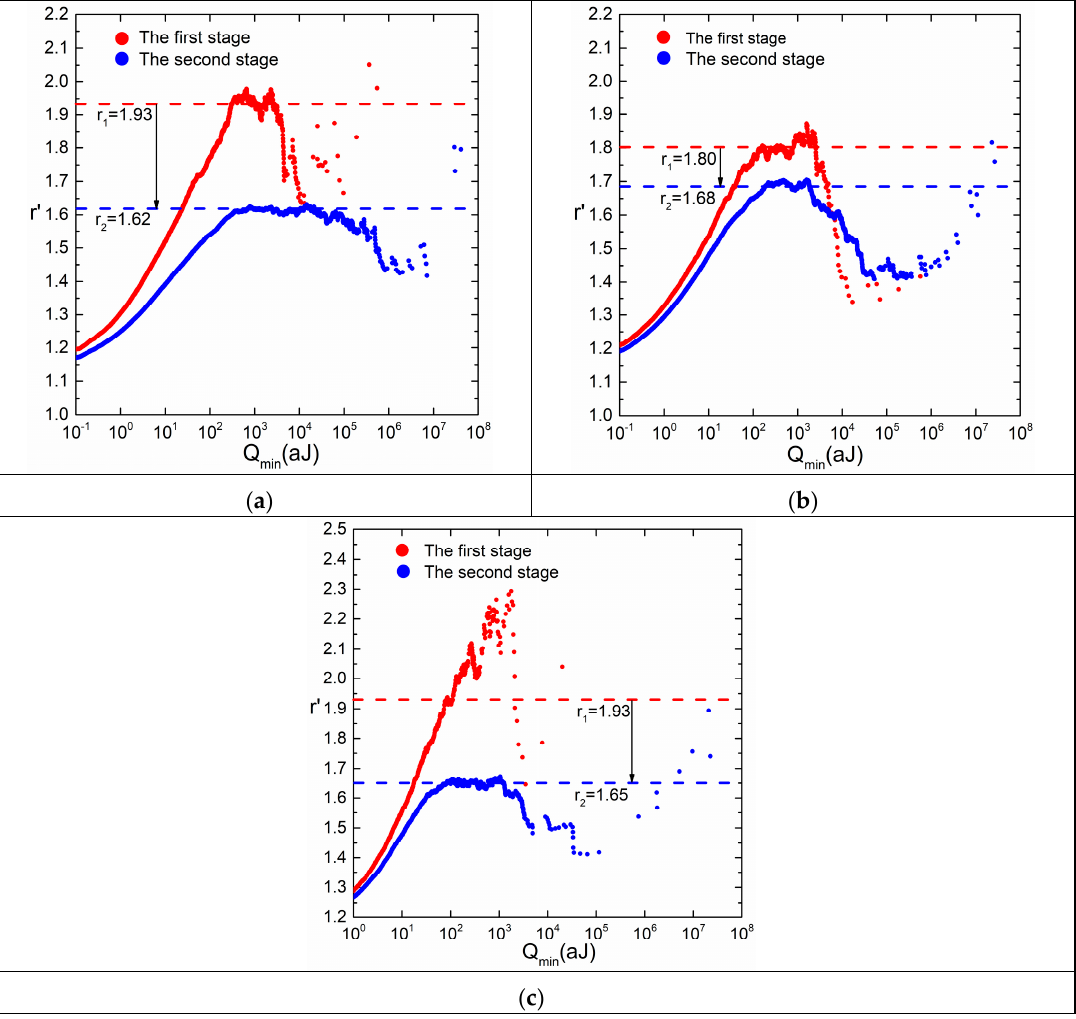
′ as a function of lower threshold Q min : ( a ) B-30, ( b ) B-45, ( c ) B-60. Figure 9. Fitted exponent r (cid:48) as a function of lower threshold Q